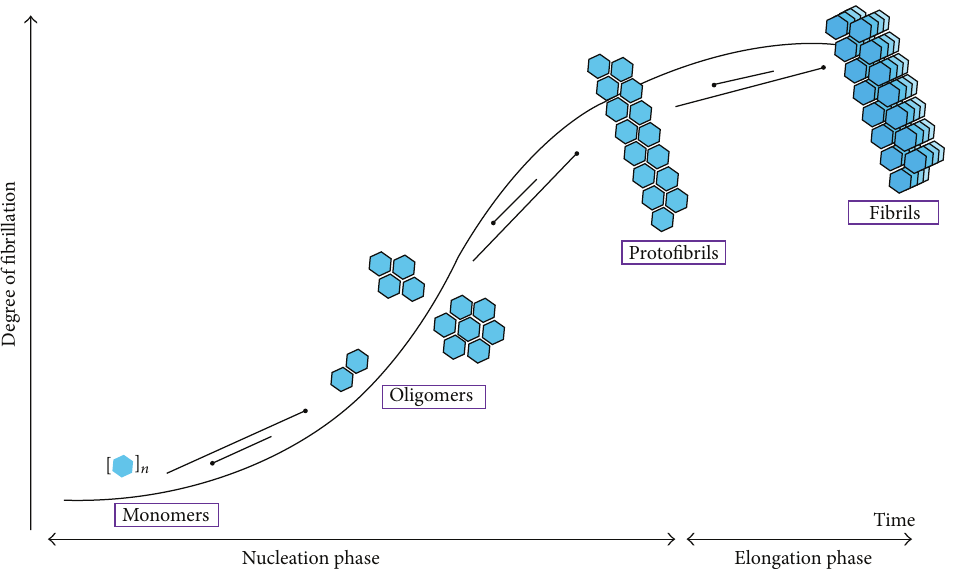
Figure 3: Schematic representation of fibrillation of hIAPP over time. During nucleation phase, hIAPP monomers associate themselves in order to form oligomers of various sizes. As the nucleation phase extends to the elongation phase, we can observe the formation of protofibrils, building blocks of the mature fibrils that characterize amyloidoses.